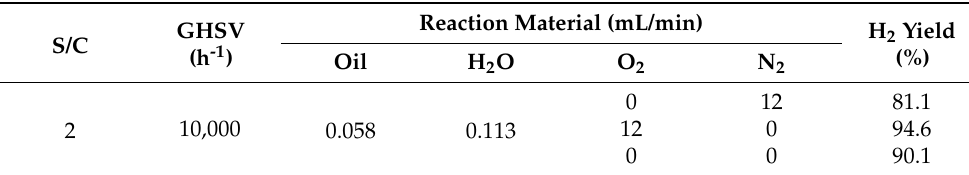
Table 5. Effect of O 2 and N 2 addition on H 2 yield.